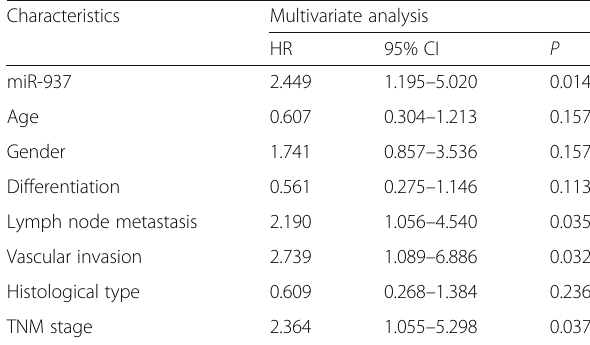
Table 2 Multivariate Cox analysis for overall survival of colon cancer